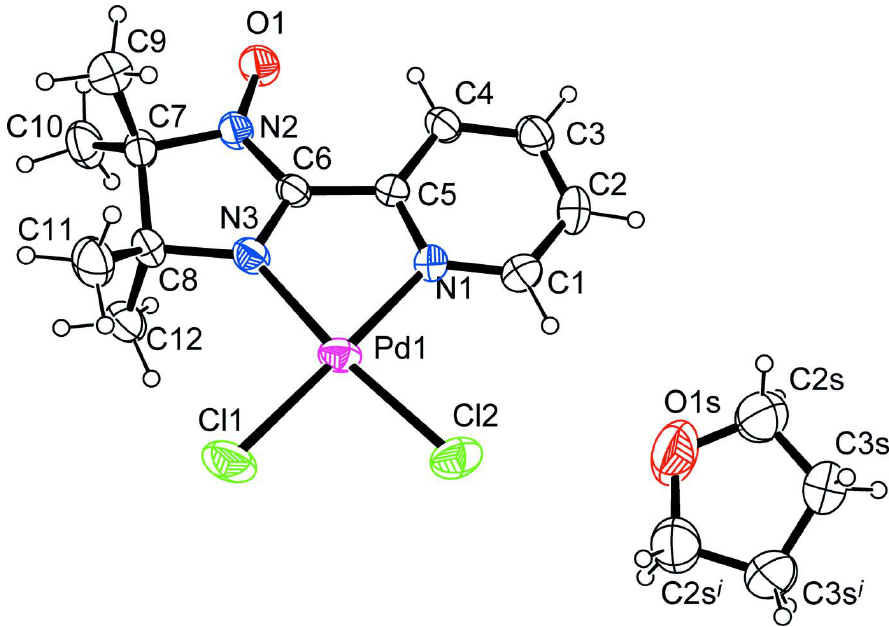
An ORTEP drawing of title compound showing 30% probability displacement ellipsoids and the atom-numbering scheme. The labels of the H atoms have been omitted for clarity. [Symmetry codes: (i) - x + 1, y , - z +